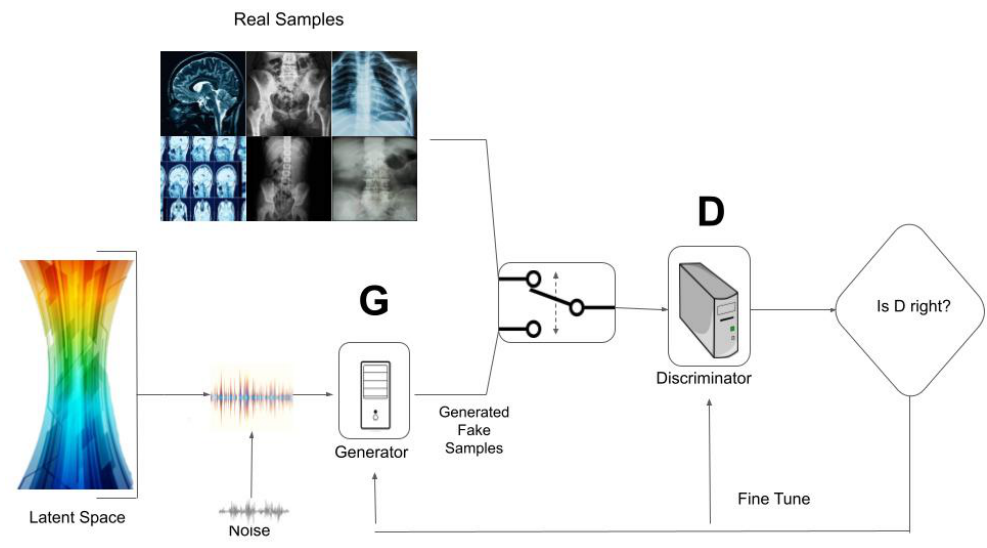
Figure 6. Structure of the GAN